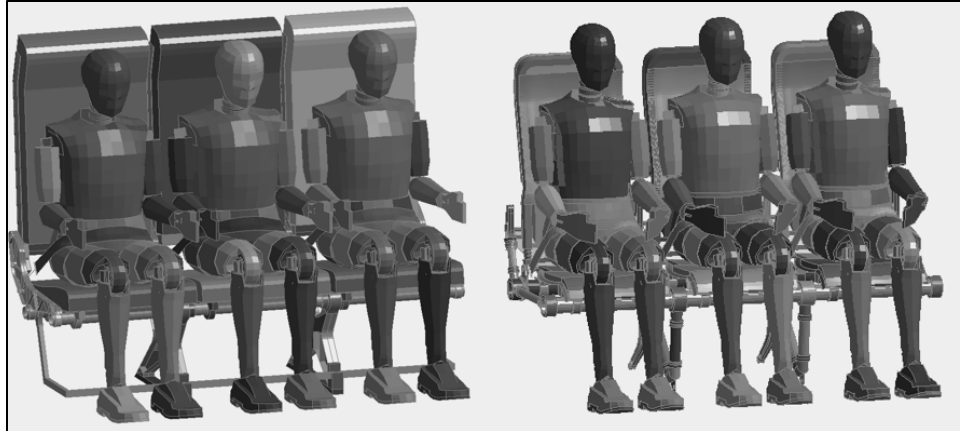
Figure 4. Aircraft seat models: Initial study model (left) and improved study model (right).